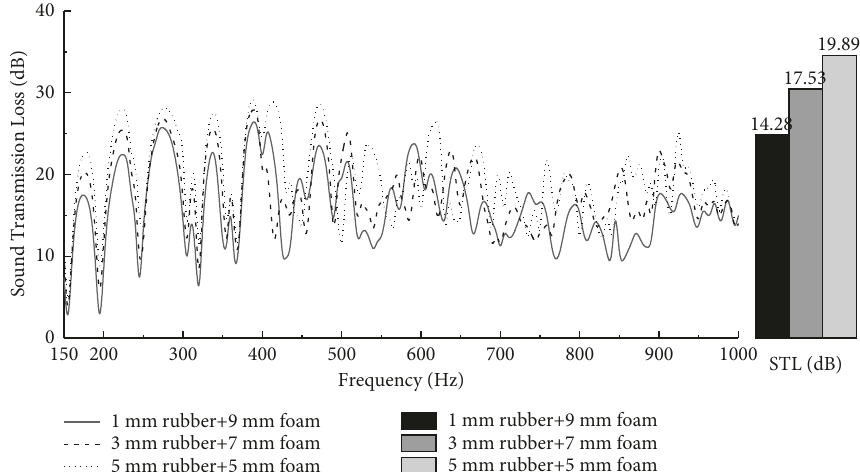
Figure 11: Comparison of laying multiple layers of the same thickness on the sound transmission loss of the cylindrical